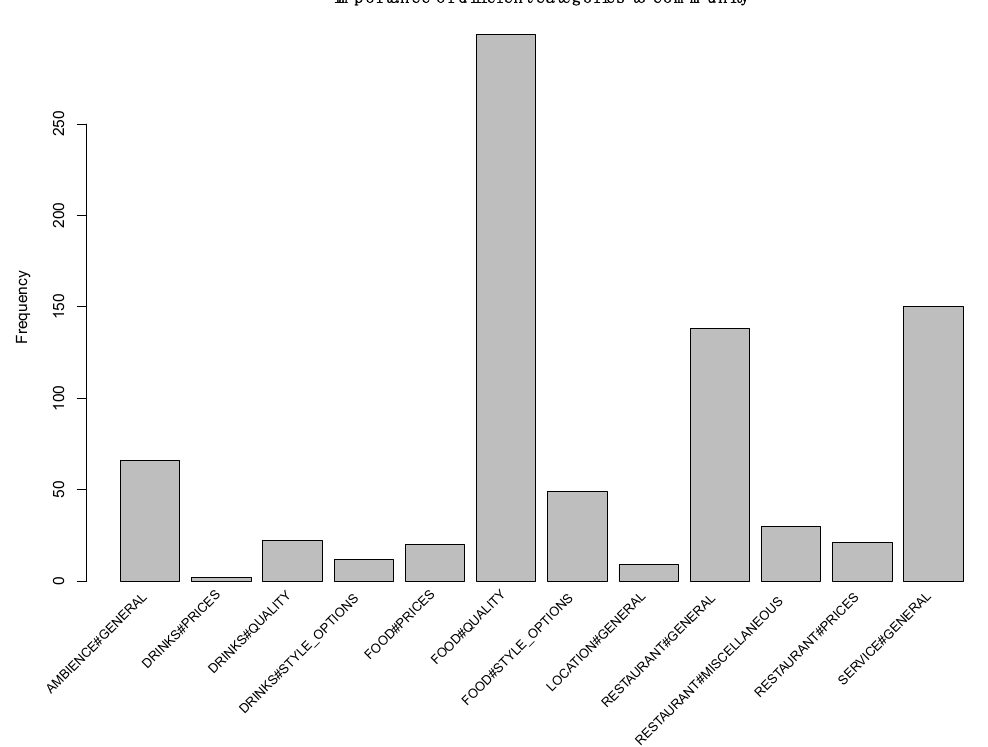
Figure 6. Importance of different aspects of the reviews calculated after completion of ACD task. Frequency represents the number of times a reviewer has commented. “Frequency” is the super set of the aspect categories for the restaurant data set. Higher frequencies represent the most commented on or discussed category in the reviews.